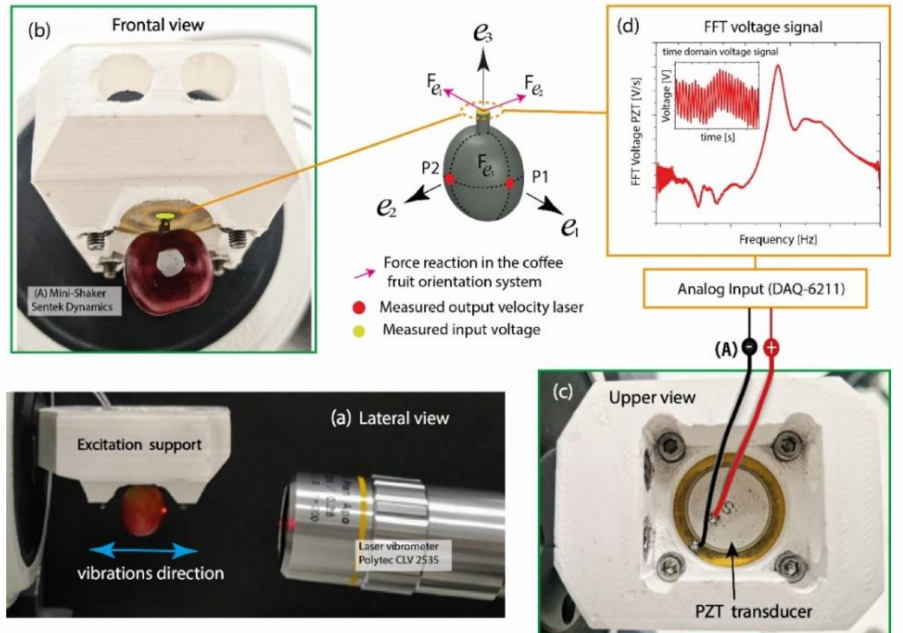
Figure 4. Experimental setup for modal analysis. ( a ) Lateral view of the experiment. ( b ) Frontal view of sample bonded to the PZT. ( c ) Upper view of the excitation support with piezotransducer and electrodes. ( d ) Representation of the FFT of input